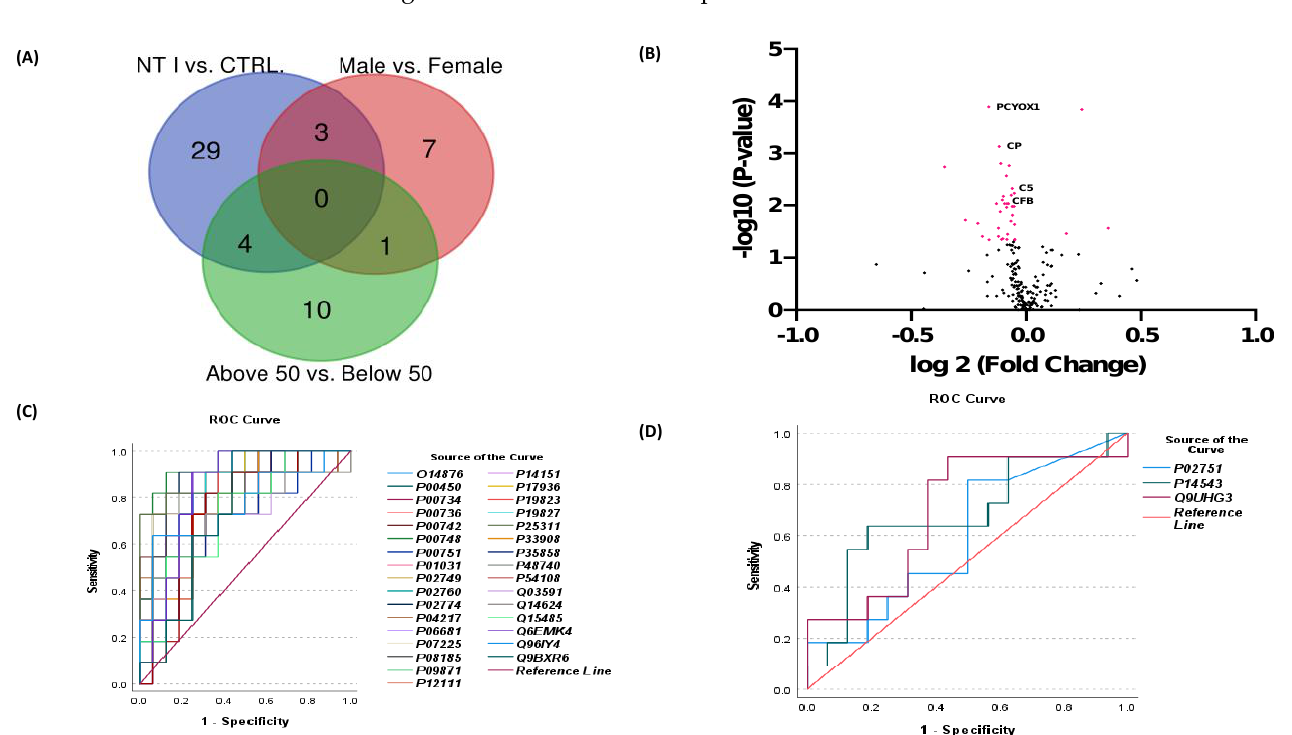
Figure 3. ( A ) Venn diagram of all identified low-abundant proteins in NT1 samples. Protein expres- sion levels are compared based on sex, age, and sample source (disease and control). ( B ) Volcano plot of all identified low-abundant proteins in NT1, proteins with p -value < 0.05 upon Mann Whitney U -test are considered significant and are colored in magenta. DEPs are above the threshold, with downregulated DEPs on the left and upregulated DEPs on the right. Receiver operating character- istic curve (ROC-AUC) for ( C ) Downregulated DEPs in NT1, the AUC score of the ROC analysis is between the range of 0.80–0.91, while the p -value is between the range of 0.0001–0.04. ( D ) In upregulated DEPs in NT1, the AUC score of the ROC analysis is between the range of 0.60–0.70, while the p -value is between 0.0001 – 0.04.